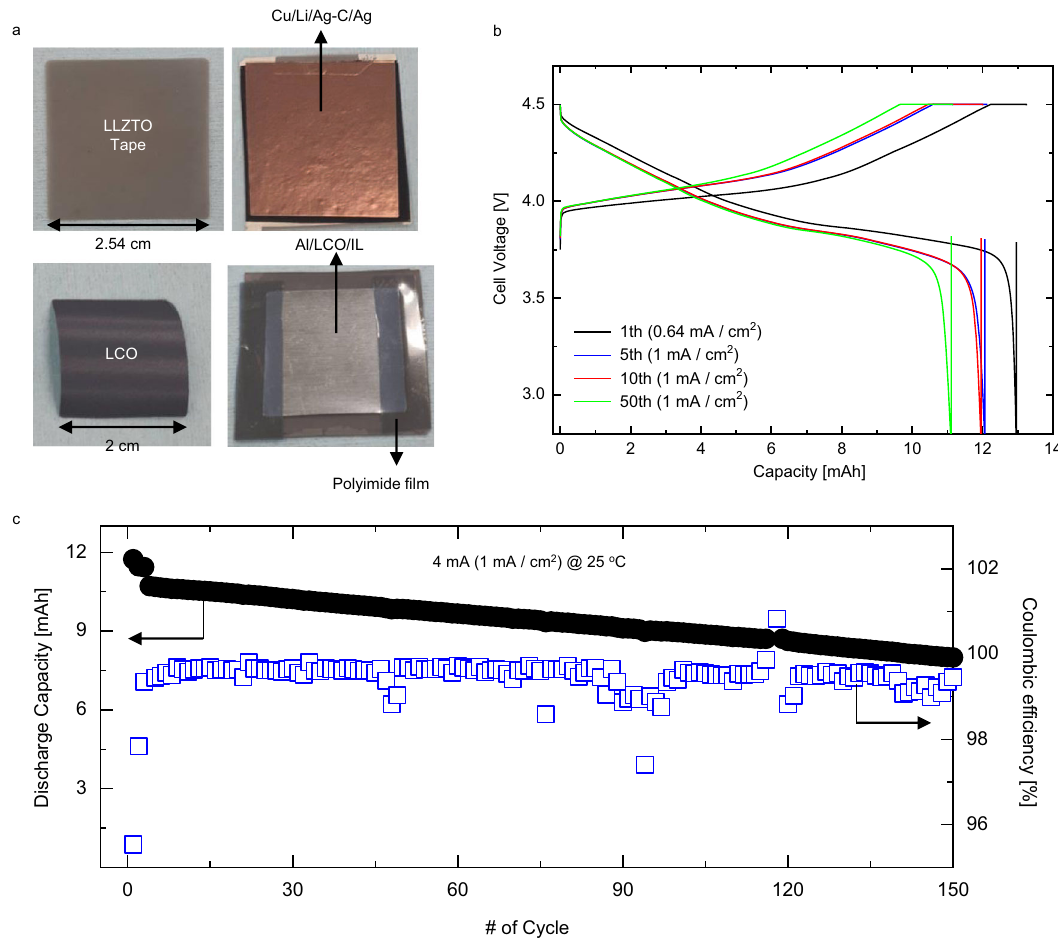
Fig. 6 | Electrochemical performance of Li|Ag-C/Ag/LLZTO/IL|LCO cell using large-area thin tape solid electrolyte. a LLZTO tape (2.53cm×2.53cm, 74mm), Cu/Li/Ag-C/AgattachedtoLLZTOtape,LCO-basedpositiveelectrode(2cm×2cm) and the assembled Li|Ag-C/Ag/LLZTO/IL|LCO cell. b Galvanostatic voltage pro fi les